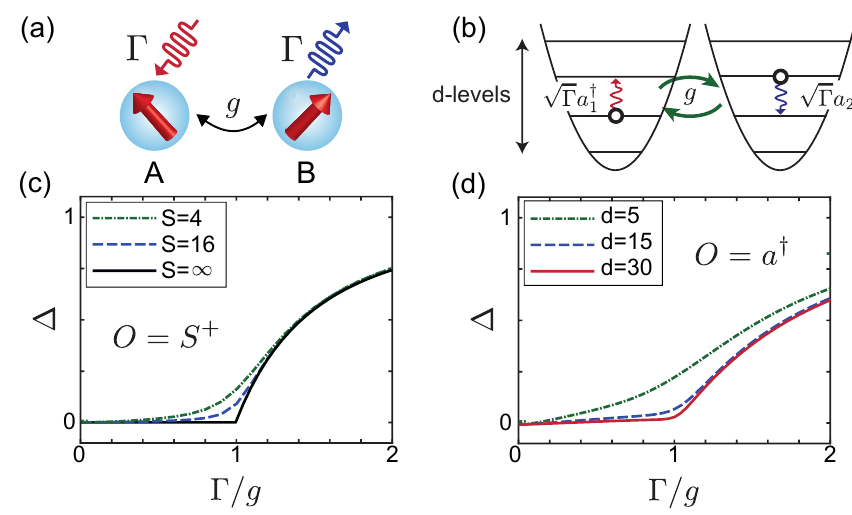
Figure 1: Two basic examples of PT -symmetric quantum systems with a finite Hilbert space dimension d : (a) two coupled spin S = ( d − 1 ) / 2 systems and (b) two coupled harmonic oscillators with a finite number of energy levels. In (c) and (d) we plot the corresponding dependence of the symmetry parameter ∆ defined in Eq. (8) on the ratio Γ / g . In (c) the line for S = ∞ is obtained from a Holstein-Primakoff approximation [ see discussion of Eq. (14) ]